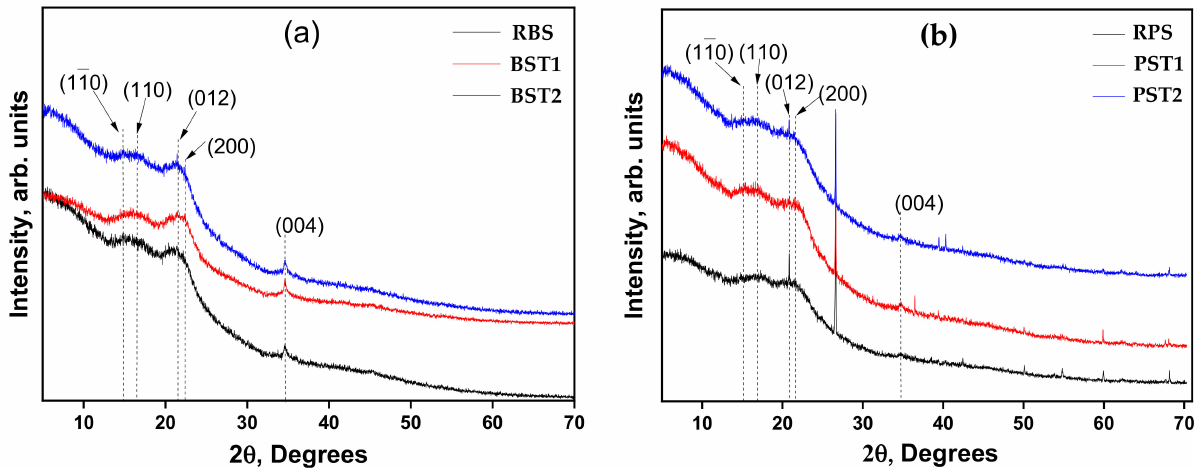
Figure 2. Powder X-ray diffraction (XRD) patterns of natural and treated bean ( a ) and pistachio ( b ) pod biomasses. (Black curve) Raw natural materials RBS and RPS, (red curve) BST1 and PST1 treated materials (treatment 1, basic–acidic method), (blue curve) BST2 and PST2 (treatment 2 with urea).